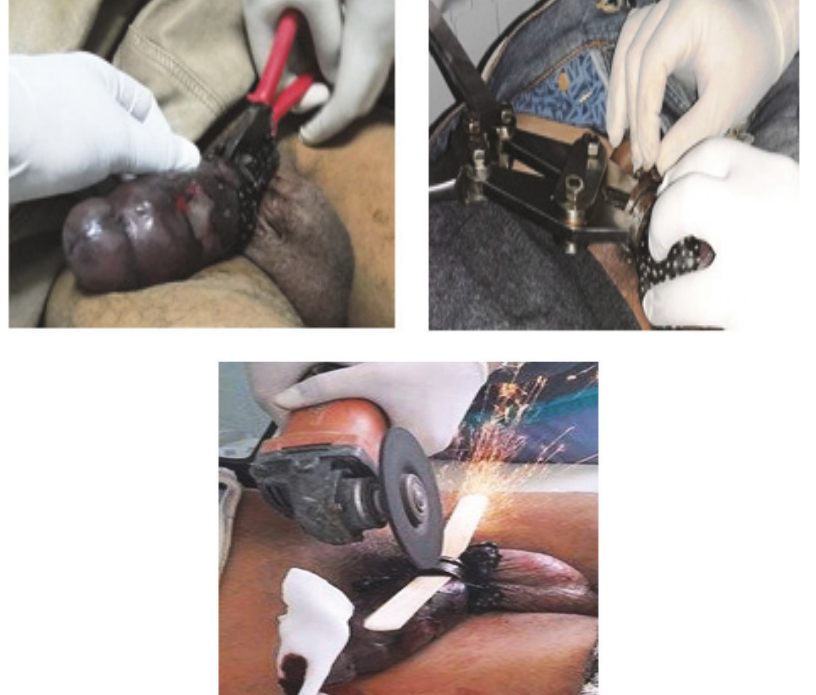
Figure 1: Different materials used for cutting the metal ring incarcerated in the root of the penis.